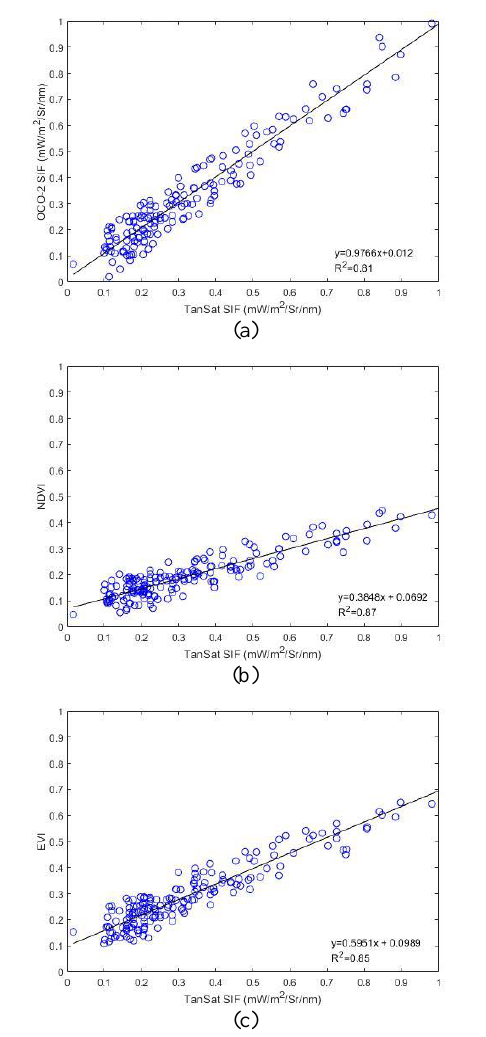
Figure 6. Scatter plots of retrieved TanSat SIF against OCO-2 SIF (a), MODIS vegetation indices (NDVI: (b) and EVI: (c))